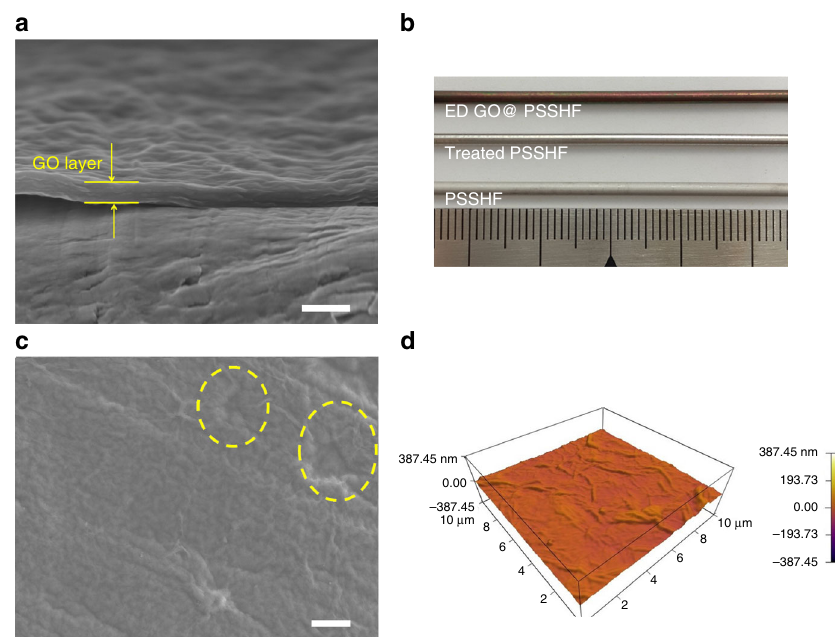
Fig. 2 Morphology of ED-GO@PSSHF membrane. SEM images of a cross-section and c surface of ED-GO@PSSHF membrane, b optical image of PSSHFs and ED-GO@PSSHF, d atomic force microscopy (AFM) measurement of ED-GO surface, scale bars a 200 nm and c 2 μ